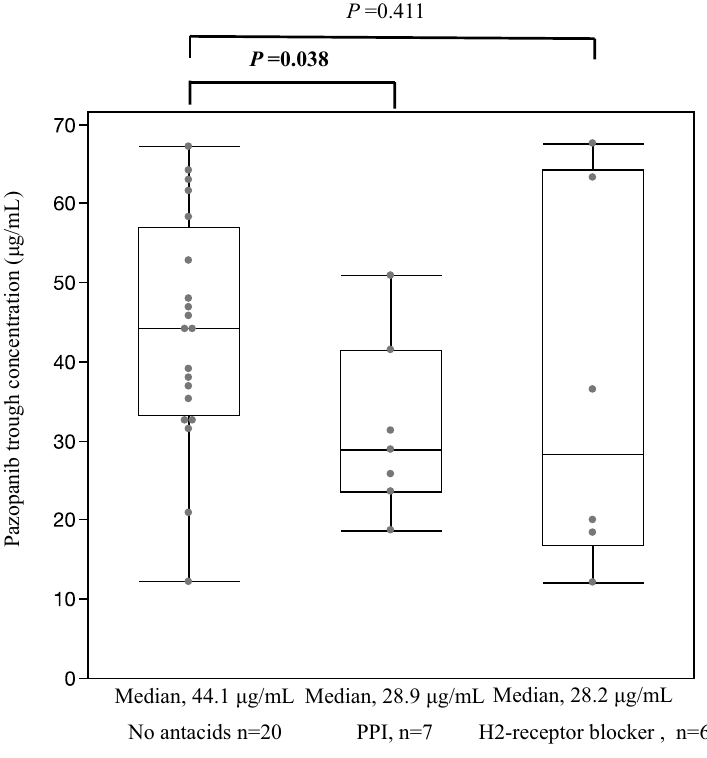
Figure 3. Influence of antacids on pazopanib plasma trough concentrations. PPI, Proton pump inhibitor; H2-receptor blocker, Histamine 2-receptor blocker. Statistical tests were compared using a Mann–Whitney U test (two-sided).